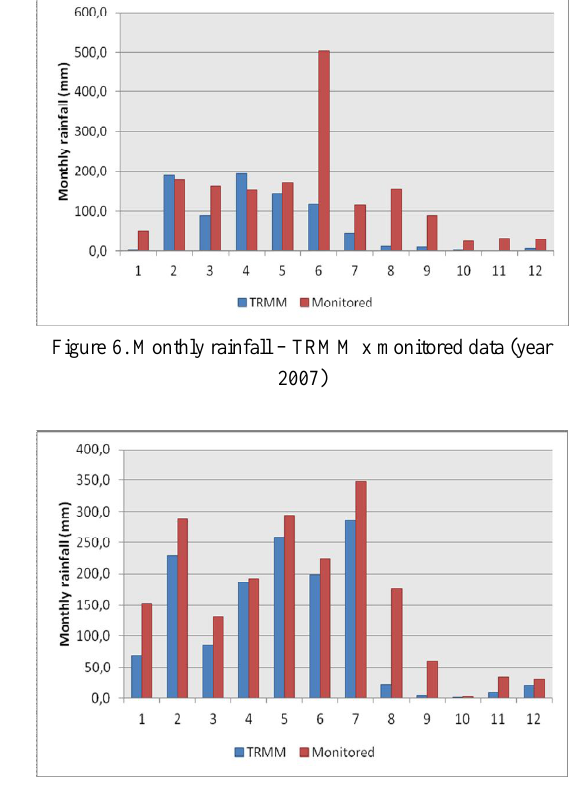
Figure 7. Monthly rainfall – TRMM x monitored data (year 2009)